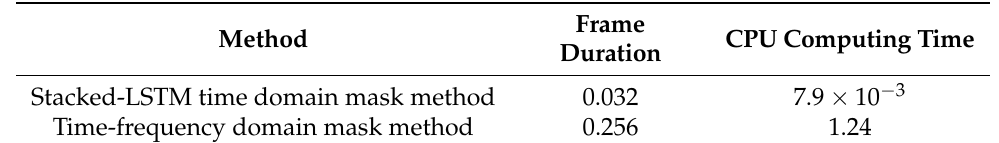
Table 4. Times per frame